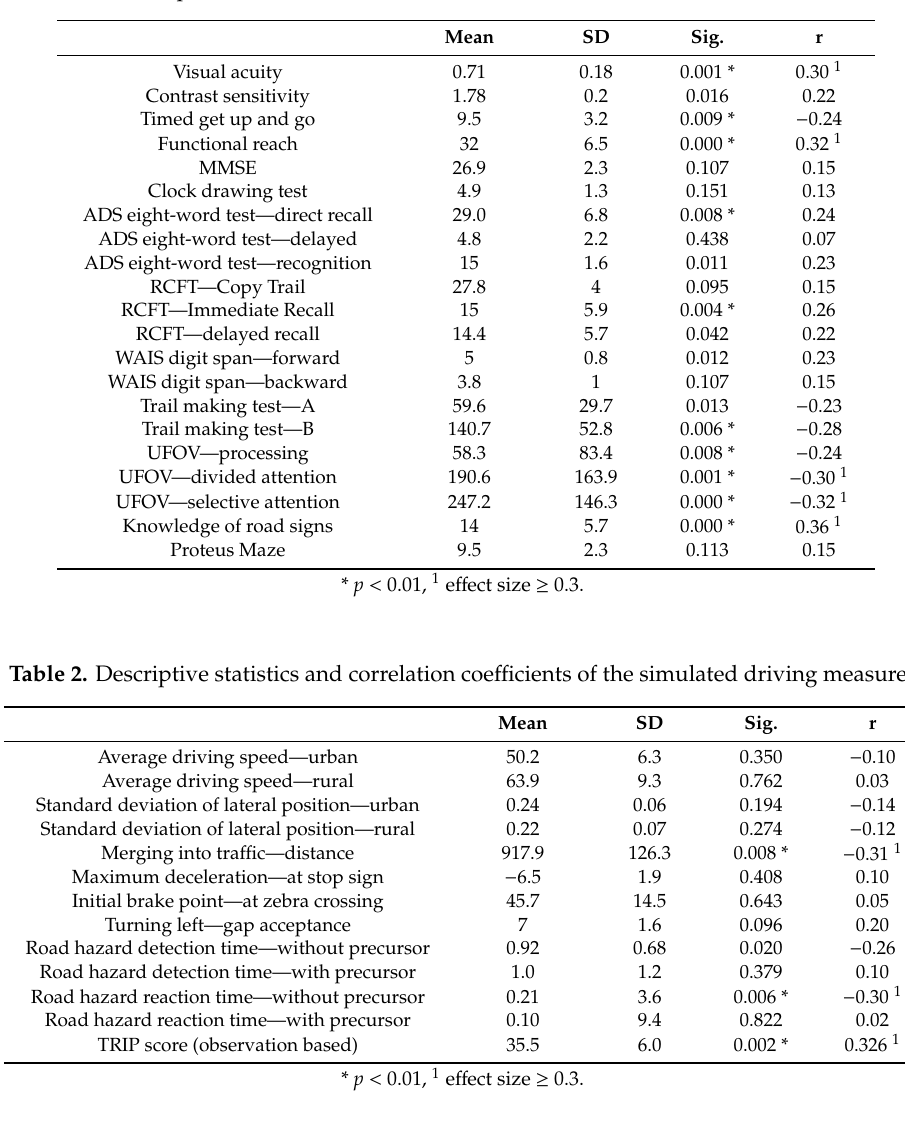
Table 1. Descriptive statistics and correlation coe ffi cients of the functional test measures.